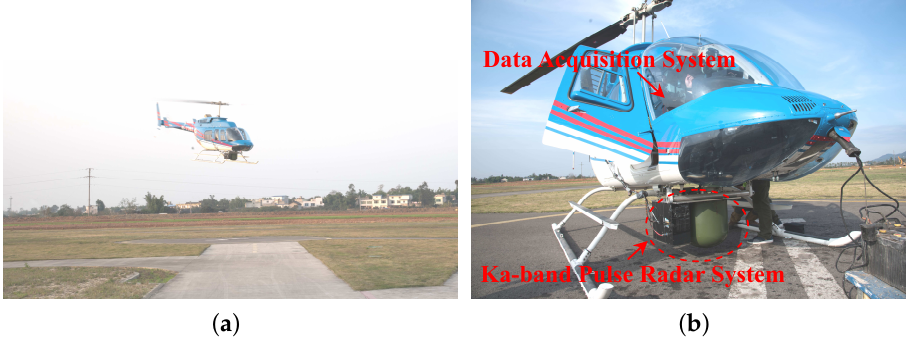
Figure 13. Experimental test platform: ( a ) Overview of the helicopter; ( b ) Onboard radar system.